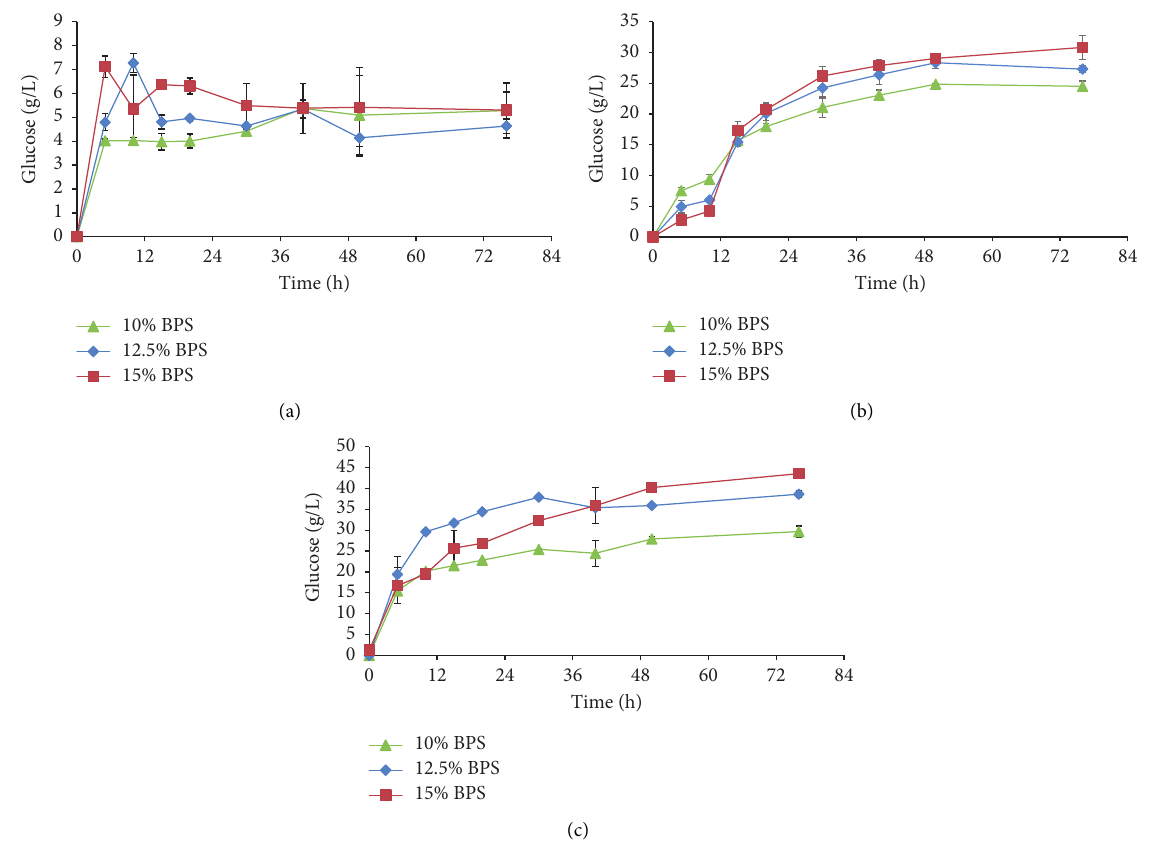
Figure 4: Time course of the pretreated BPS by the crude enzyme from T. longibrachiatum LMLSAUL 14-1: (a) acid; (b) LHW; (c)